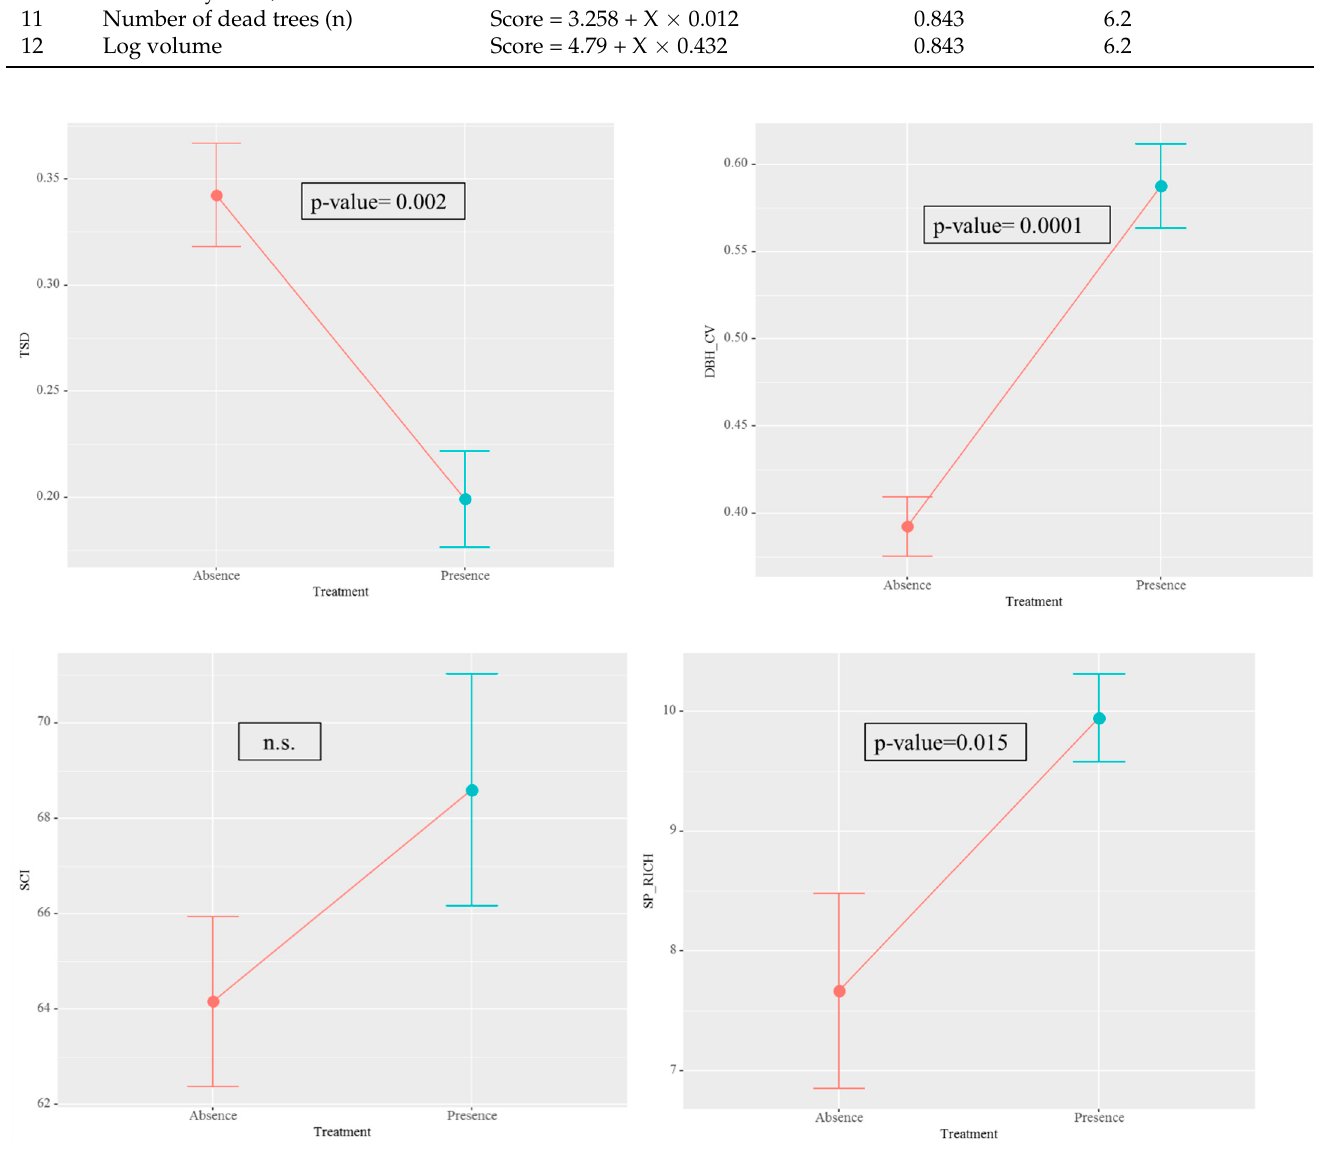
Figure 4. Differences in some attributes in two pseudo-absence and presence locations of the Cau- casian grouse (n.s—non-significant).